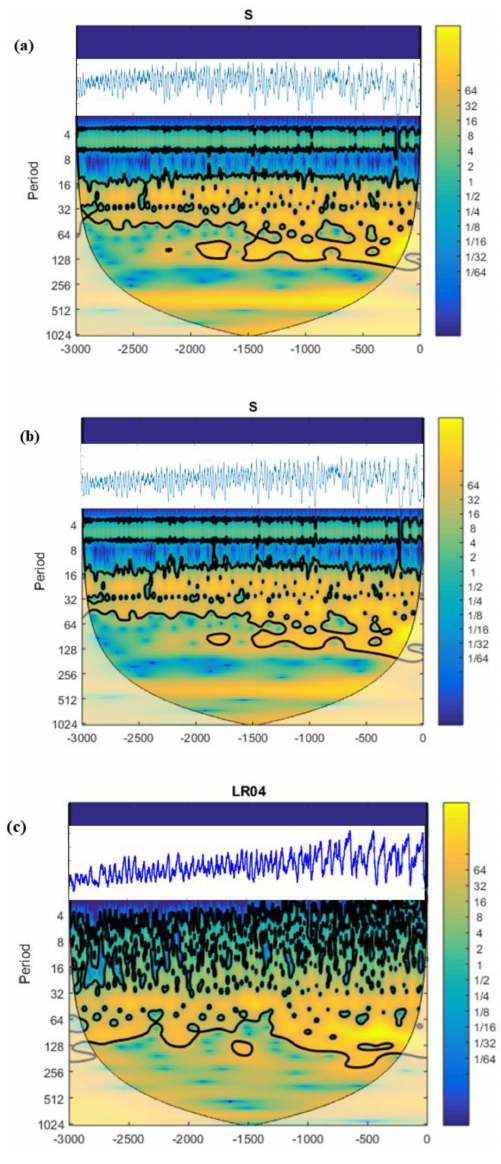
Figure 1. Ice–climate system response to a cooling trend presented as an evolution of wavelet spectra over 3Myr for calculated ice- sheet glaciation area S (10 6 km 2 ) ( a and b ) and for the Lisiecki and Raymo (2005) benthic δ 18 O record ( c ). The V number evolves from V = 0.5 to V = 0.75 due to weakening of the negative feedback (a) and due to intensified positive feedback (b) . The vertical axis is the period (kyr); the horizontal axis is time (kyr before present). The color scale shows the continuous Morlet wavelet amplitude, the thick line indicates the peaks with 95% confidence, and the shaded area indicates the cone of influence for wavelet transform. Inserts are corresponding time